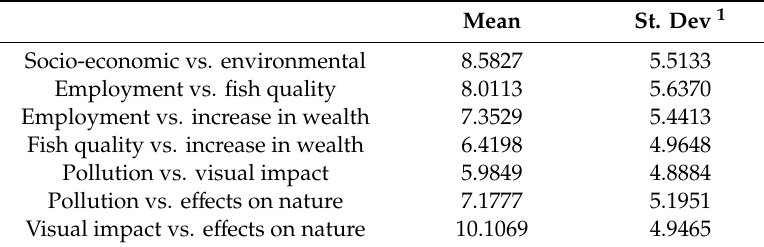
Table 5. Comparison of